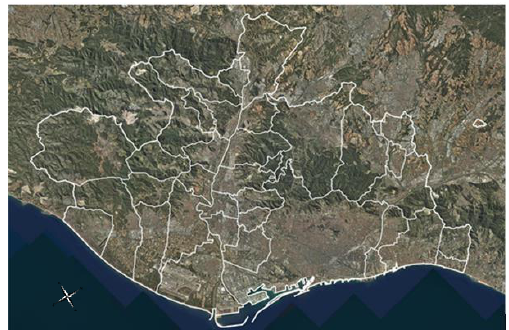
Figure 1 . Metropolitan Area of Barcelona (with